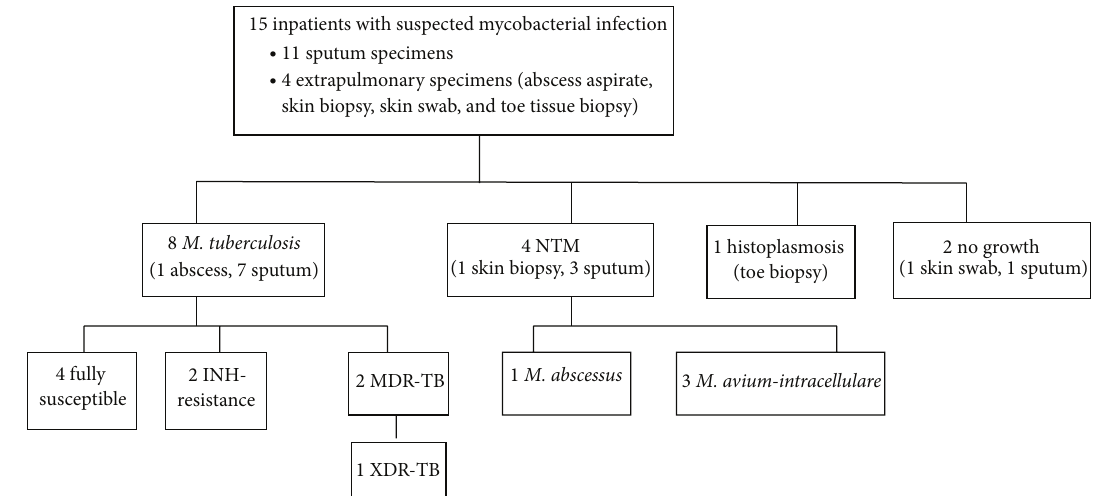
Figure 2: Hospital inpatients with suspected mycobacterial